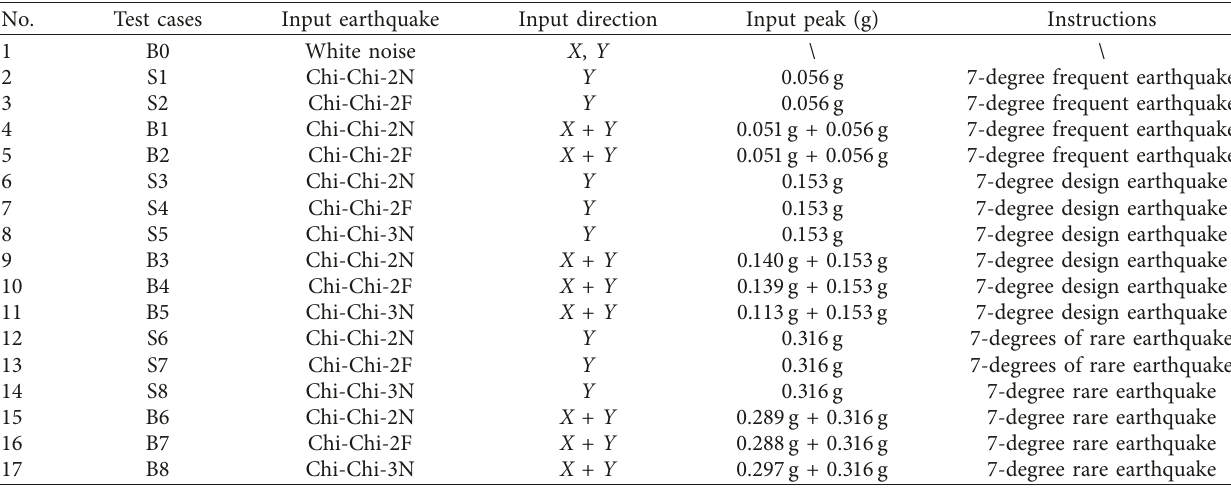
Table 3: Test cases.